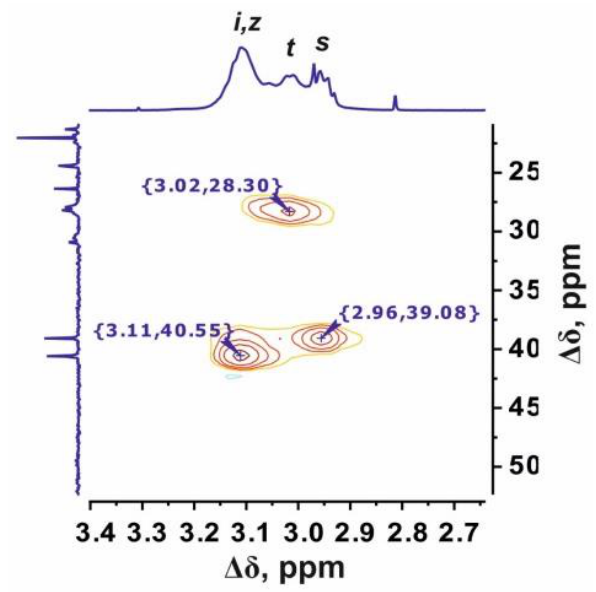
Figure 5. 1 H- 13 C HSQC NMR spectrum of the Lys-His-Arg dendrimer in the range of 3.40–2.65 ppm at 298